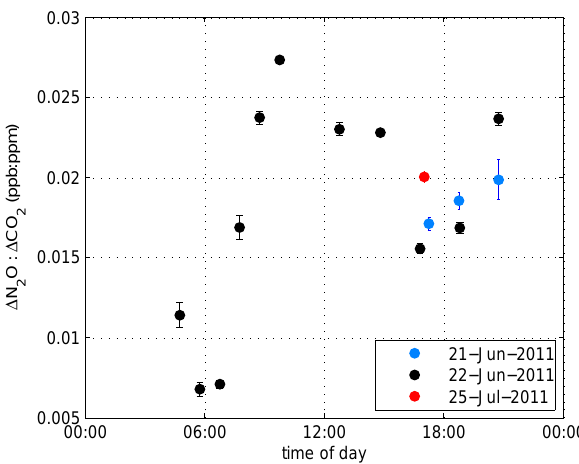
Fig. 7. 1 N 2 O: 1 CO 2 ratios for groups of exit-entrance flasks sam- pled in parallel, shown against time of day. Different colours indi- cate different sampling